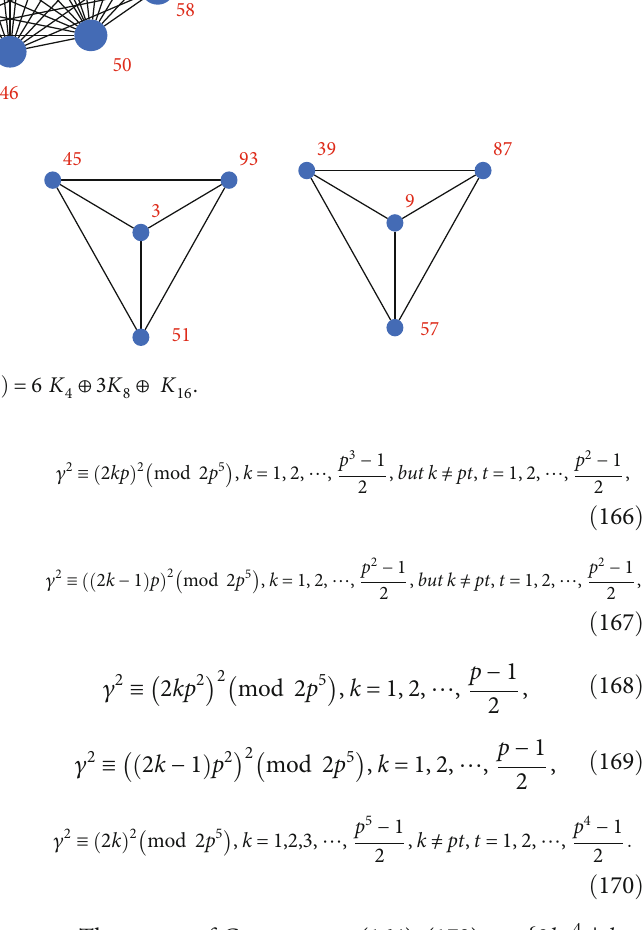
Figure 4: ~ G ð 2, 96 Þ = 6 K